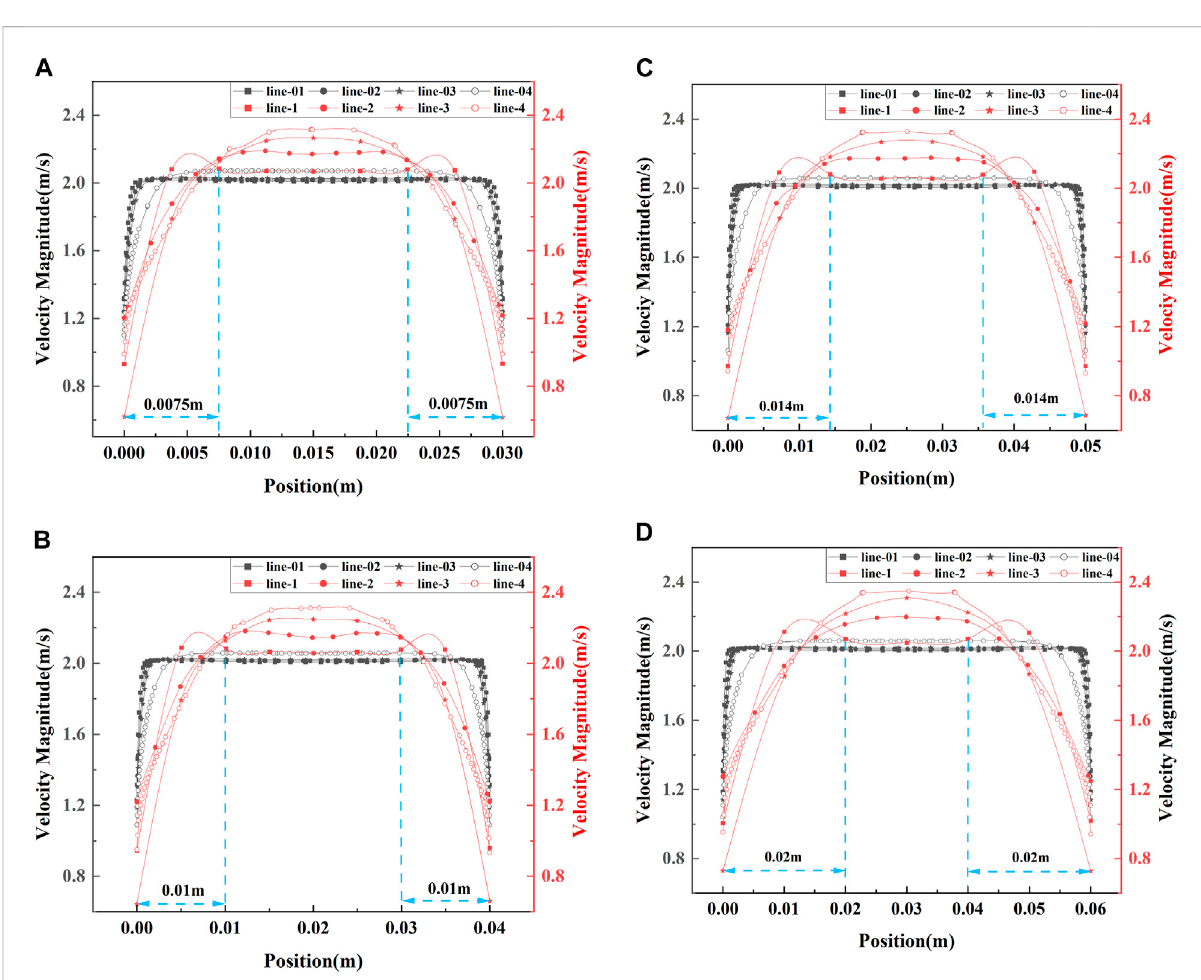
FIGURE 12 Velocity distribution along lines in the line plan: (A) model 1, (B) model 2, (C) model 3, (D) model 4.